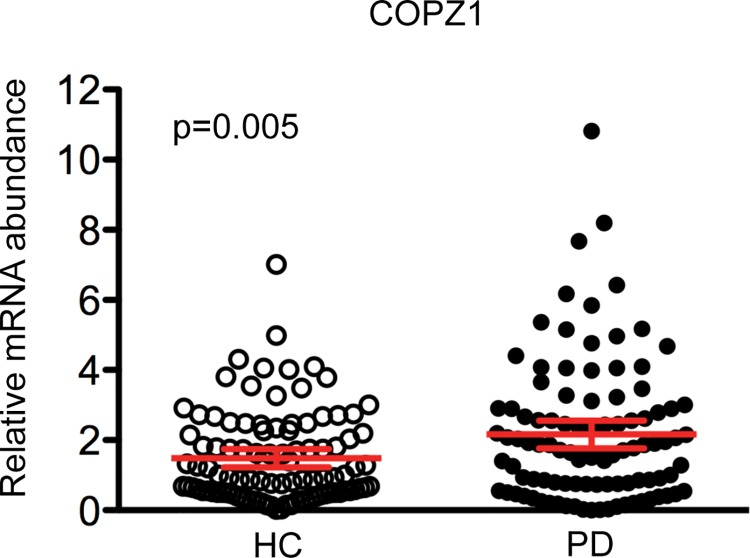
Relative abundance of COPZ1 mRNA in the PPMI study.Relative abundance of COPZ1 in PD patients (black circles) compared to HC (white circles). Relative abundance of COPZ1 was calculated using GAPDH mRNA as a reference gene. Error bars represent the 95% confidence interval. A p-value of less than 0.005 was regarded as significant based on a Student t-test (two-tailed).